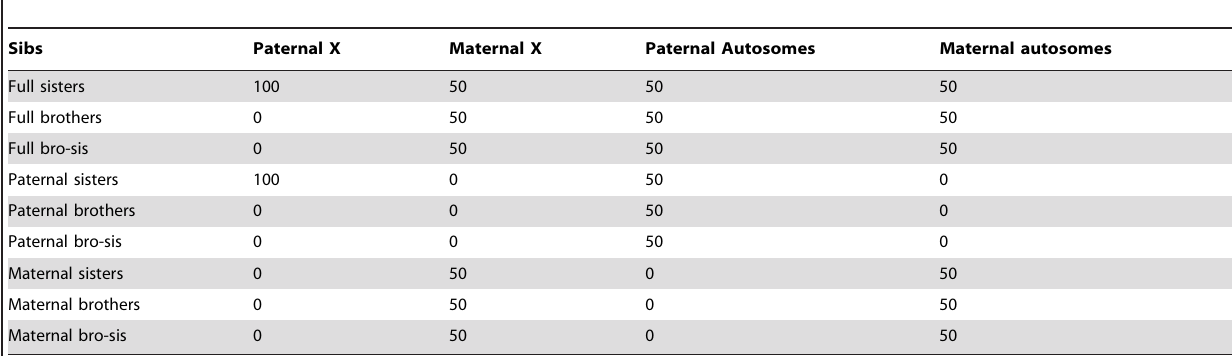
Table 1. Mean percentage DNA shared by full and half-siblings by chromosome